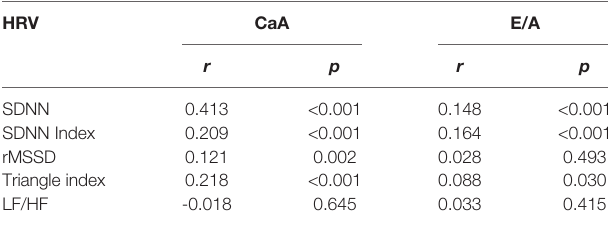
TABLE 3 | Correlation coef fi cients between CaA, E/A, and HRV variables.